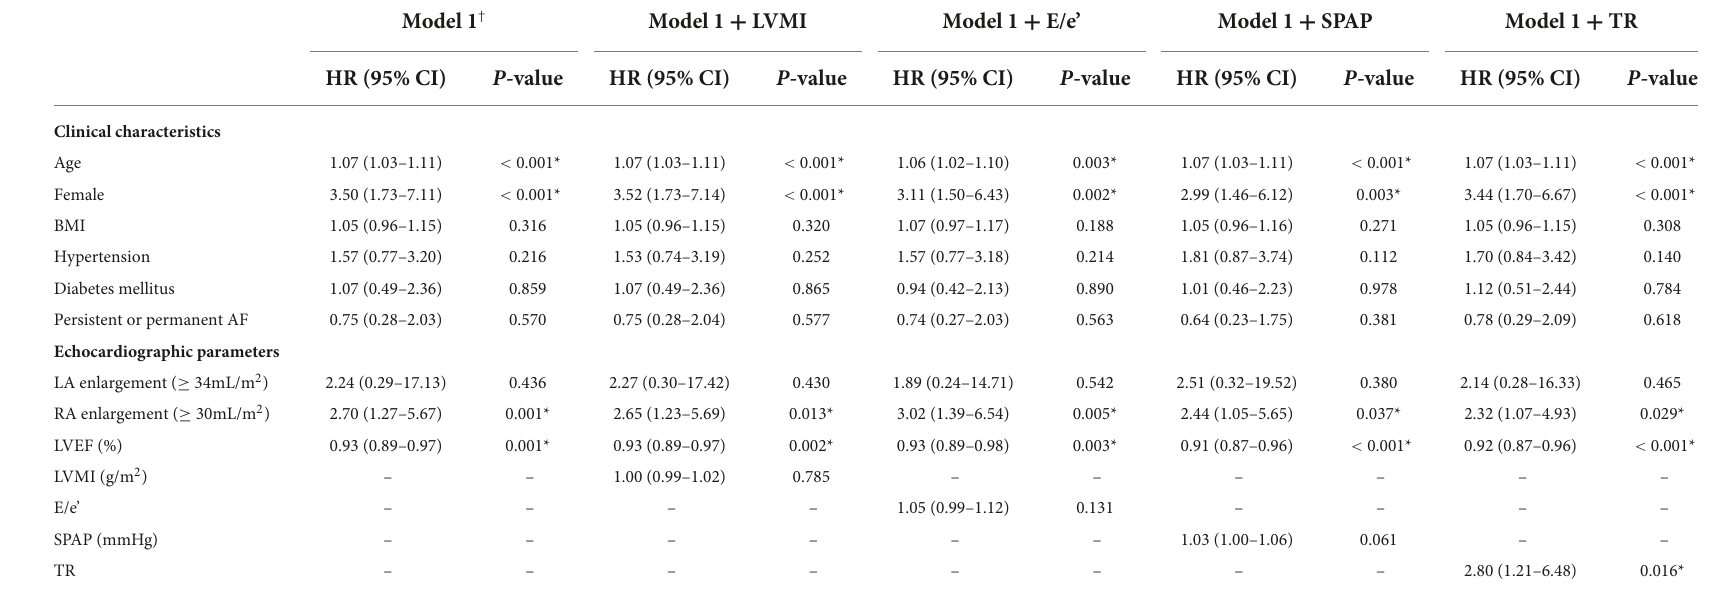
TABLE 4 Multivariate Cox proportional hazard analysis for composite end–point of HHF or all cause